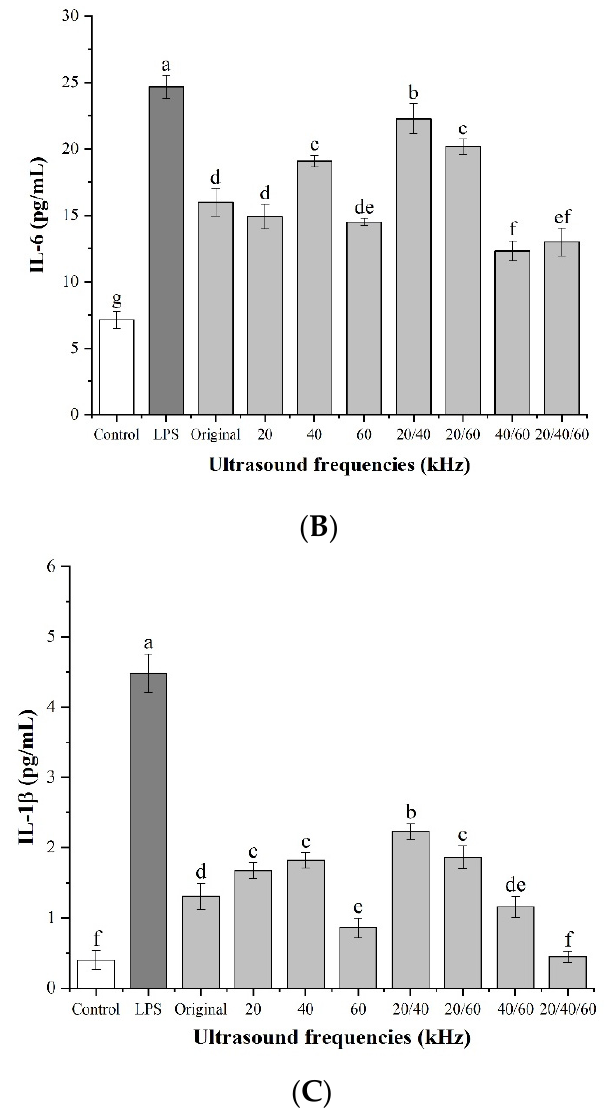
Figure 7. Cytokine secretion: ( A ) TNF- α ; ( B ) IL-6; ( C ) IL-1 β . Different lowercase letters denote a statistically significant difference at p < 0.05 and p < 0.01 with the control group.